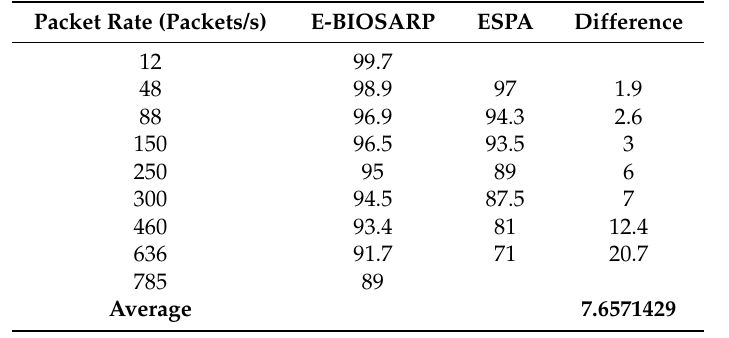
Table 10. Energy consumption